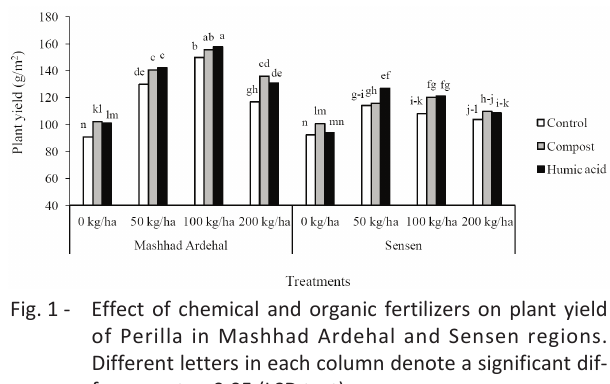
Fig. 1 - Effect of chemical and organic fertilizers on plant yield of Perilla in Mashhad Ardehal and Sensen regions. Different letters in each column denote a significant dif- ference at p≤0.05 (LSD